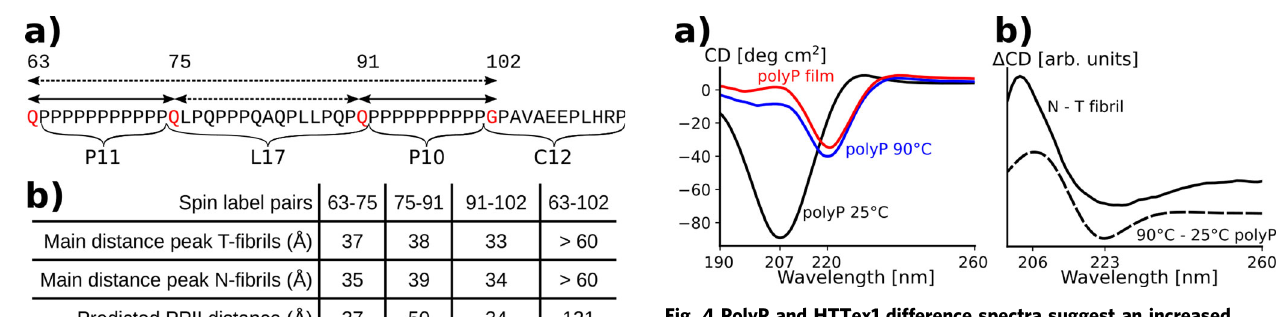
Fig. 4 PolyP and HTTex1 difference spectra suggest an increased entanglement of the PRDs in N compared to T- fi brils. a CD spectra of polyPro at a concentration of 0.1mg/ml recorded at 25°C (black) and 90 °C (blue). The spectrum in red was recorded after the spectrum at 90°C and Fig. 3 Long-range distance inside the PRD of N- and T- fi brils is highly after removing the liquid from the CD cuvette indicating the formation of a similar. a Sequence of the PRD indicating the positions of the labels polyP fi lm inside the cuvette. b Difference of N- and T- fi bril CD spectra of introduced for distance measurements in red and the distance pairs as Fig. 1 (solid line) and polyP CD spectra recorded at 90 and 25°C (dashed arrows. The segments of the PRD including the two polyP regions (P11 and line). The shared maxima at about 206 nm and minima at about 223nm P10) and the linker region (L17) and C-terminals region (C12) are also indicate that the structural differences that occur during heat-induced polyP indicated. b Table listing all distances measured via EPR DEER experiment fi lm formation are comparable to those between HTTex1 N and T- fi for each spin label pair and fi bril type. The distance corresponds to the maximum of the main peak derived from the DEER decay curve (DEER data and fi ts are shown in Supplementary Fig. 2). In addition, the theoretical distances for a polyP II helix assuming an increase of 3.1 Å per residue and the theoretical radius of gyration ( R G ) for a random coil, are given ( R G = R 0 N ν with R = 1.927 Å, ν = 0.598, and N is the number of residues). Both 0 distances spanning the polyP regions (P11 and P10) correspond nicely to a PPII distance. The distance spanning the L17 region is signi fi cantly shorter than a PPII helix and longer than expected for a random coil structure.